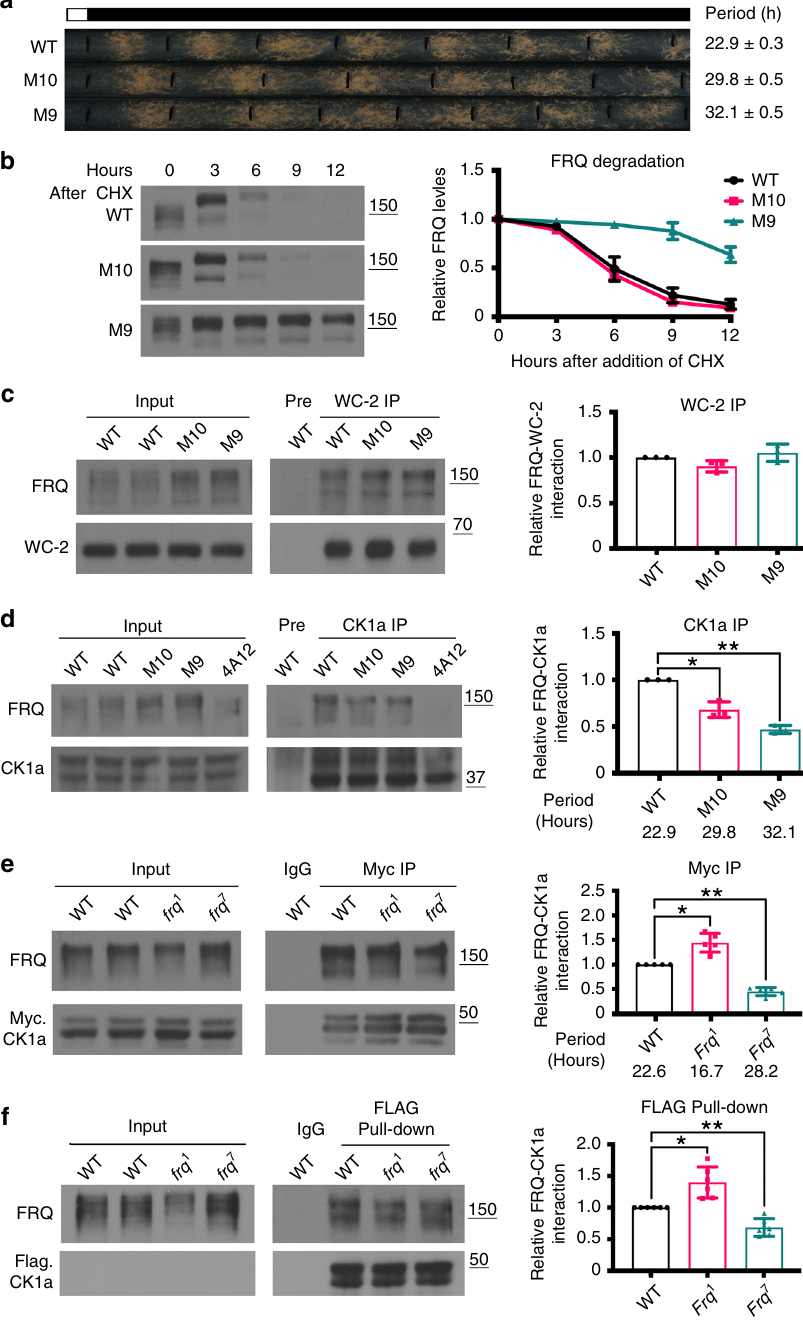
Fig. 1 Period correlates with FRQ-CK1a interaction, but not with FRQ stability. a Race tube assay showing the circadian conidiation rhythms of two FRQ phosphorylation site mutants M9 and M10. Error bars are standard error of mean ( n = 6). b Western blot analysis showing FRQ degradation pro fi les in the indicated strains after the addition of CHX. Both of hyper- and hypo-phosphorylated forms of FRQ are included in the quanti fi cation. The densitometric analysis results are shown on the right. Error bars indicate standard deviations ( n = 3). The position of the molecular weight marker is indicated. c WC-2 immunoprecipitation assay in the M9 and M10 mutants. Quanti fi cation of relative FRQ-WC-2 interaction levels is based on the ratio of IP to Input and normalized with WC-2 level. The densitometric analysis is shown on the right. Error bars indicate standard deviations ( n = 3). d CK1a immunoprecipitation assay in M9 and M10 mutants. Quanti fi cation of relative FRQ-CK1a interaction levels is based on the ratio of IP to Input and normalized with CK1a level. The densitometric analysis is shown on the right. Error bars are standard deviations ( n = 3). * P < 0.05, ** P < 0.01. Student ’ s t-test was used. e c-Myc immunoprecipitation assay in the wild-type, frq 1 , and frq 7 strains that express Myc.CK1a. Strains were cultured in LL. The densitometric is shown on the right. Error bars are standard deviations ( n = 5). * P < 0.05, ** P < 0.01. Student ’ s t -test was used. f FLAG-CK1a pull-down in wild-type, frq 1 , and frq 7 extracts. Recombinant FLAG-CK1a was incubated with the extracts, and anti-FLAG was used to immunoprecipitate FLAG-CK1a. Quanti fi cation of relative FRQ-CK1a interaction levels is based on the ratio of IP to Input. The densitometric analysis is shown on the right. Error bars are standard deviations ( n = 6). * P < 0.05, ** P < 0.01. Student ’ s t -test was used. All strains were cultured in LL. Source data are provided as a Source Data fi